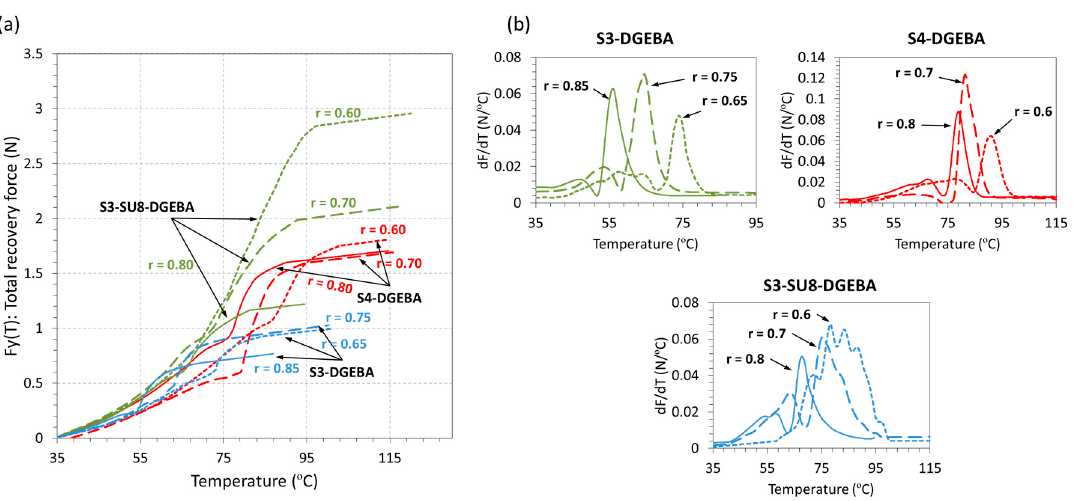
Figure 10. Shape-memory fully-constrained recovery experiments: ( a ) thermal force subtraction process; ( b ) force generated after subtracting the thermal contribution.